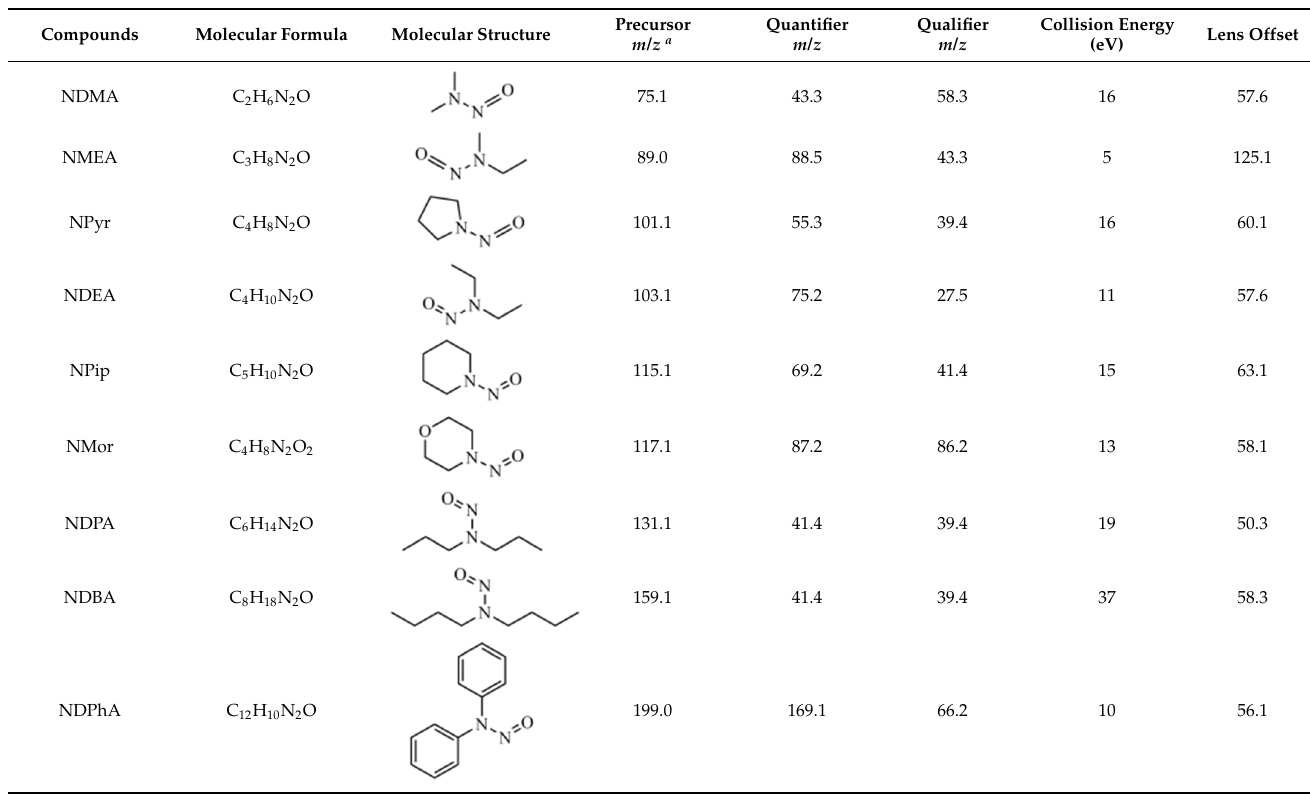
Table 3. Molecular structure and optimized MRM parameters for 9 N-nitrosamines.